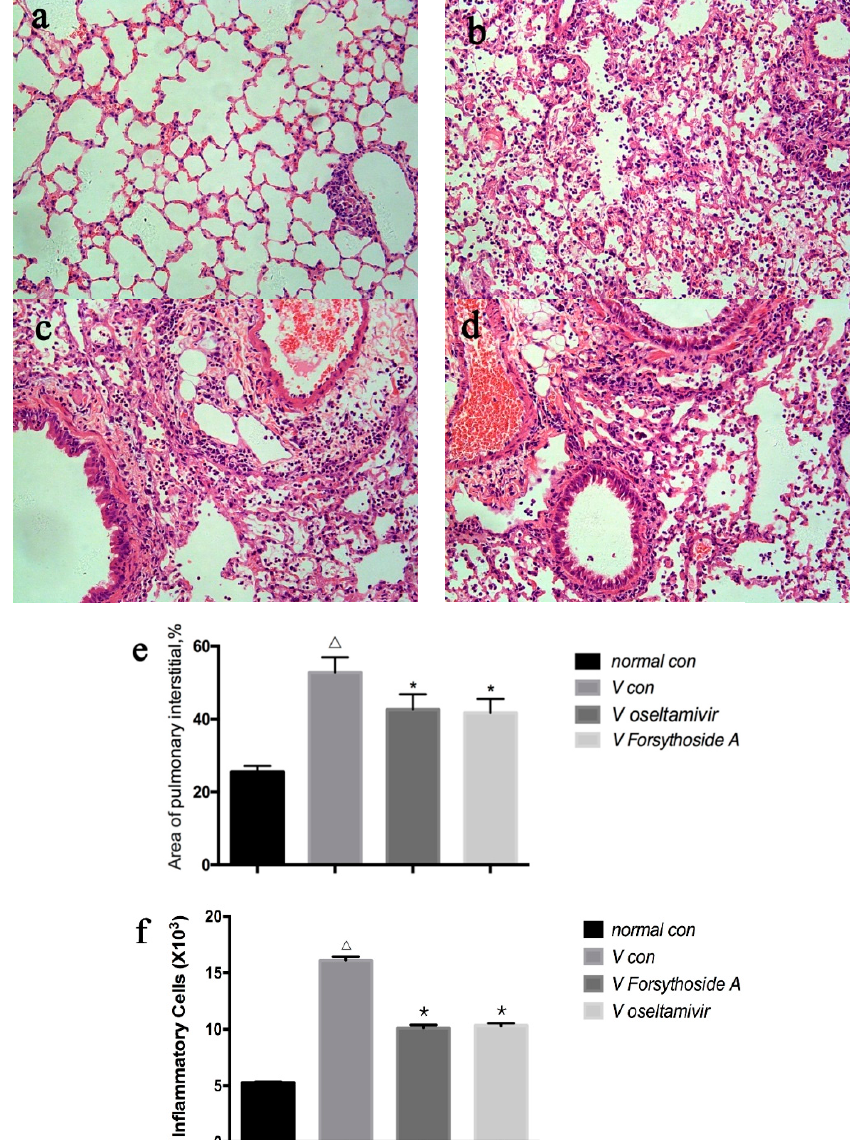
Figure 3. Effects of forsythoside A on the histological characterization in mice. ( a – d ) Representative hematoxylin and eosin staining histological sections of all the groups at day 6 (( a ) normal con ; ( b ) V con ; ( c ) V Forsythoside A ; ( d ) V oseltamivir group); ( e , f ) Changes in inflammatory cell counts and degree of edema in pulmonary interstitial. All images obtained at ×200 magnification. Δ p < 0.01 compared with normal con . * p < 0.01 compared with V con .